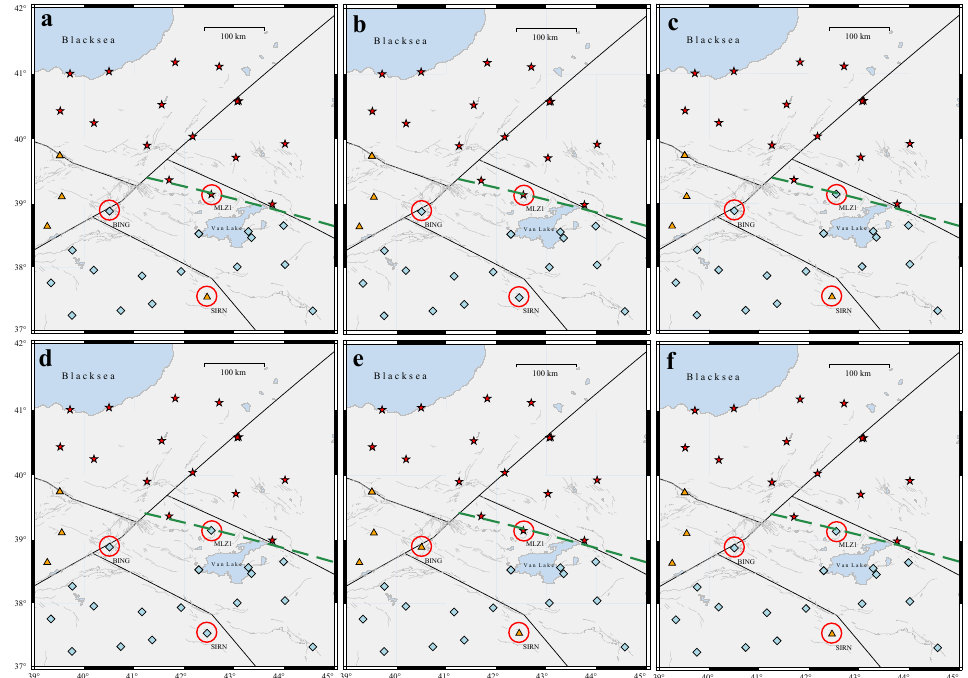
Figure 8. Comparison of clustering results with ensemble clustering for eastern Turkey with: ( a ) BIRCH; ( b ) HAC; ( c ) k -means; ( d ) mini batch k -means; ( e ) spectral clustering; ( f ) MCLA results. Red circles show the differences between algorithms. Black solid lines are the block model at [5]. The green dashed line is our block border according to the ensemble clustering result. Gray thin lines show active faults